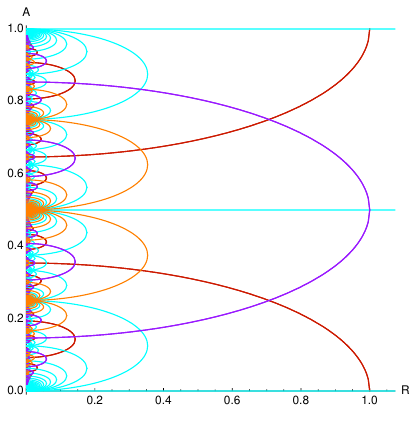
Figure 23. SO(32) heterotic with Wilson line A I = (( A ) 16